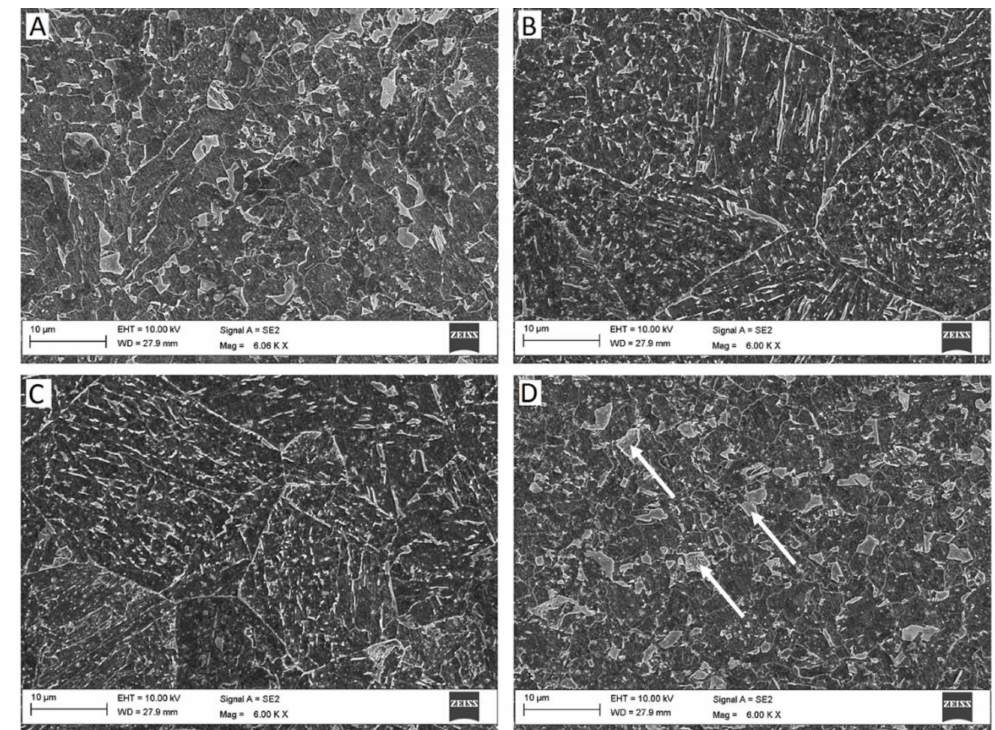
Figure 17. SEM images from high heat input weld (t 8/5 = 20 s) HAZ for steel S700MC-2. ( A – D ) are locations established in Figure 13.